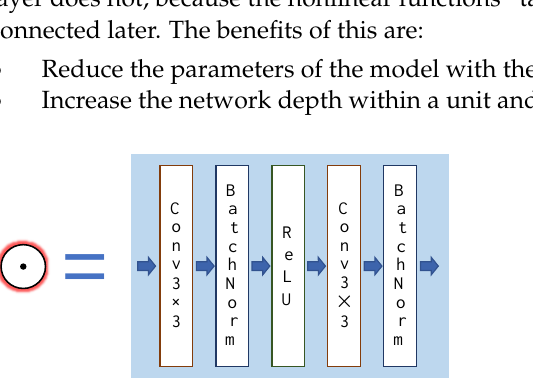
Figure 4. “ Double-layer convolution filter ” (The black point in the red circle in Figure 3). It Figure 4. “Double-layer convolution filter” (The black point in the red circle in Figure 3). It contains 5 operations in a series, which are Conv3 × 3, BN, ReLU, Conv3 × 3 and BN. The equations of the Causal LSTM can be presented as